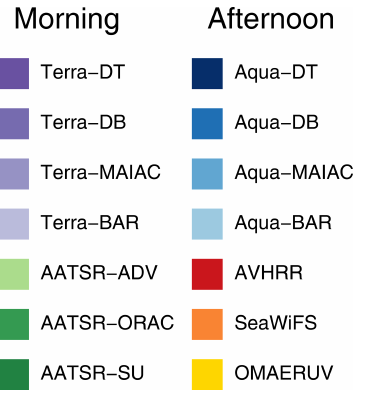
Figure 1. Colour legend used throughout this paper to designate the different satellite products, organized by approximate local Equator crossing